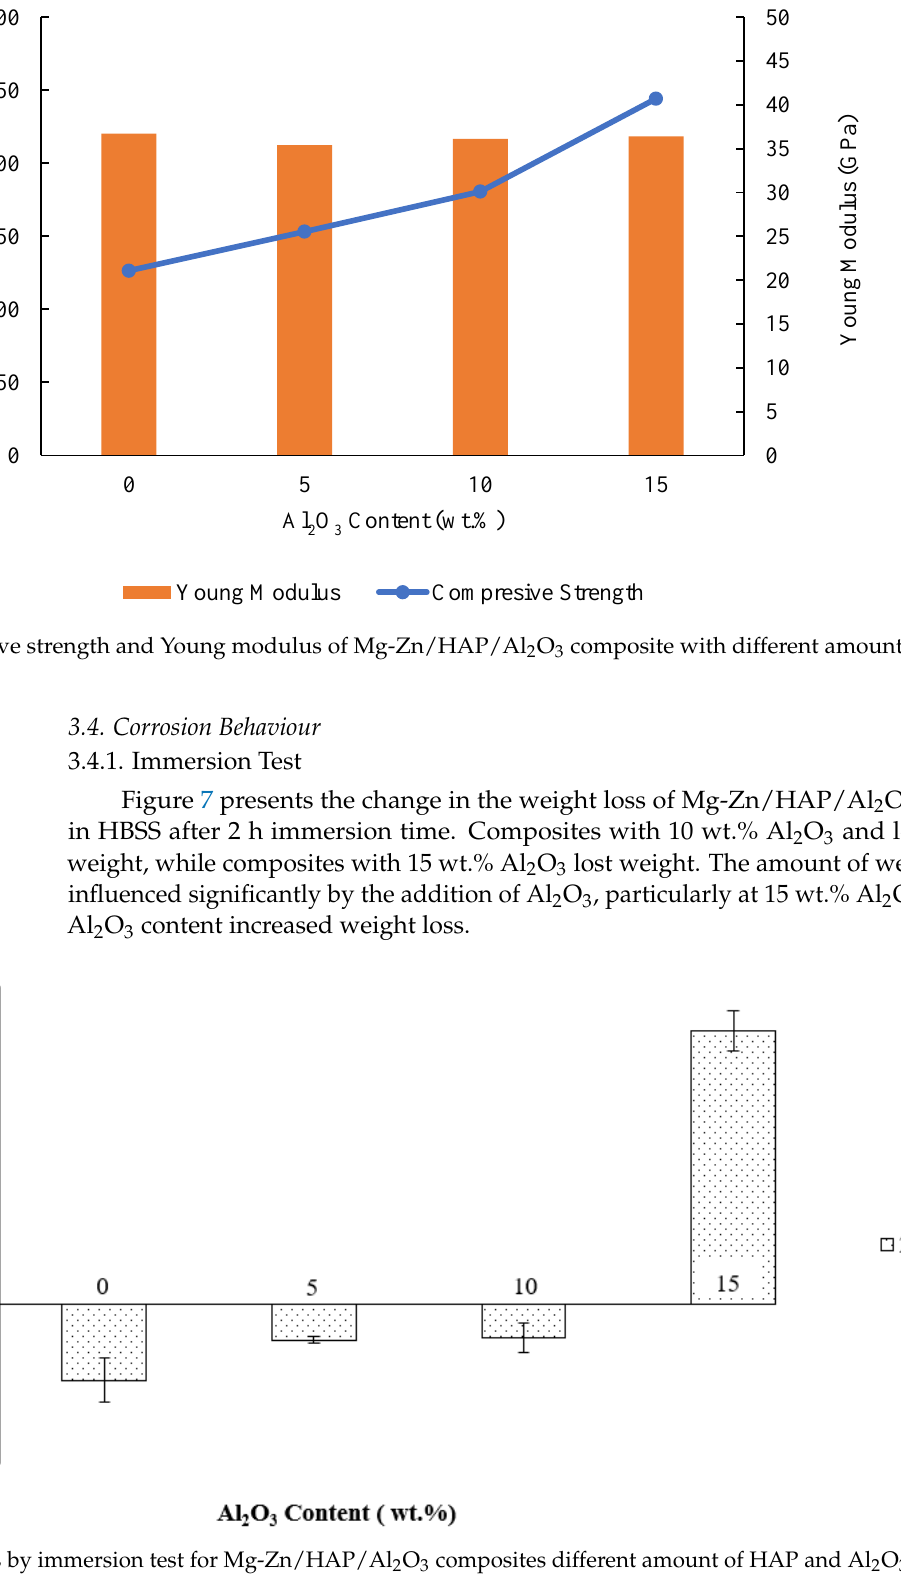
Figure 7. Weight loss by immersion test for Mg-Zn/HAP/Al 2 O 3 composites different amount of HAP and Al 2 O 3 after 2 h immersion in HBSS